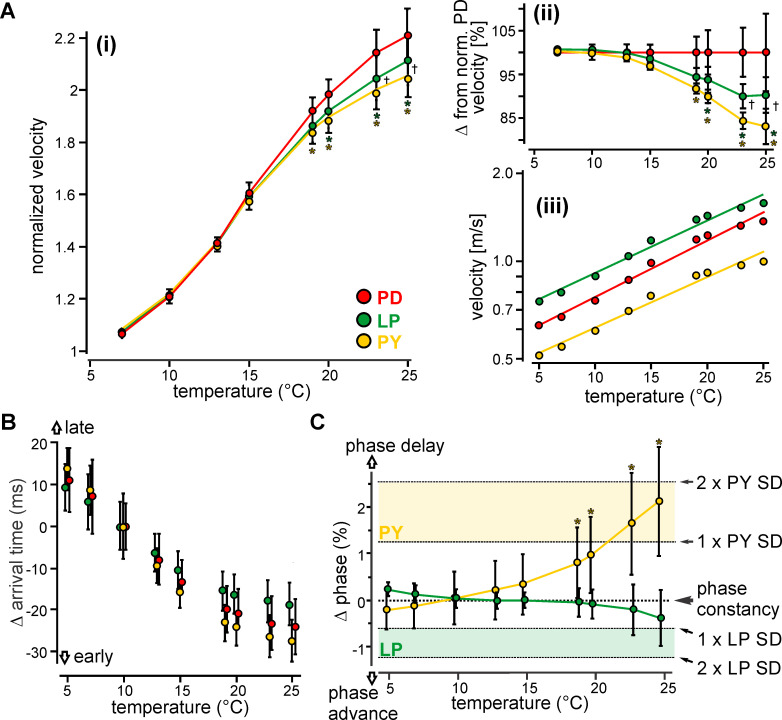
Small and coordinated temperature-induced changes in propagation velocity between the pyloric axons support temperature-robust timing over long distances.(Ai) Propagation velocity of pyloric neurons at temperatures between 5°C and 25°C. Data were normalized to the respective velocities at 5°C. (Aii) Propagation velocities of LP and PY were additionally normalized to PD to visualize the differences in propagation velocities at temperatures of 19°C and above. Asterisks denote significant differences from PD. Crosses denote significant differences between LP and PY. * p<0.05, † p<0.05. (Aiii) Linear regression fits of the propagation velocities of the pyloric neurons as a function of temperature. (B) Deviation in arrival time at the axon terminal (4cm from initiation sites in the STG) from the arrival time measured at 10°C of each pyloric neuron. Negative deviations indicate APs arrived earlier than at 10°C, while positive deviations indicate APs arrived later than at 10°C. (C) Percent deviation in phase near the axon terminal of LP and PY relative to the pacemaker neuron PD. Phase deviation was calculated from the change in propagation velocity across different temperatures. Phase constancy was calculated based on [14]. The standard deviations (SDs) of the individual neurons were calculated based on the variability in burst onset during spontaneous pyloric rhythms. Asterisks denote significant changes in phasing from phase constancy.